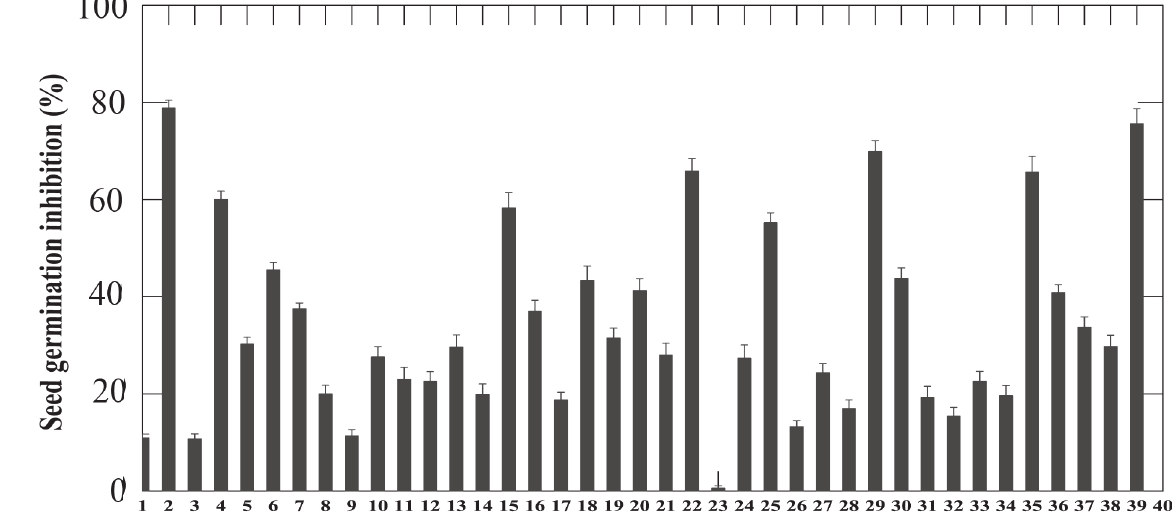
Fusarium Figure 2b. Toxicity of the Fusarium isolates on the seed germination of Orobanche ramosa . The numbering of the 39 Fusarium isolates is as in Tables 1 and 2. Error bars are standard errors.